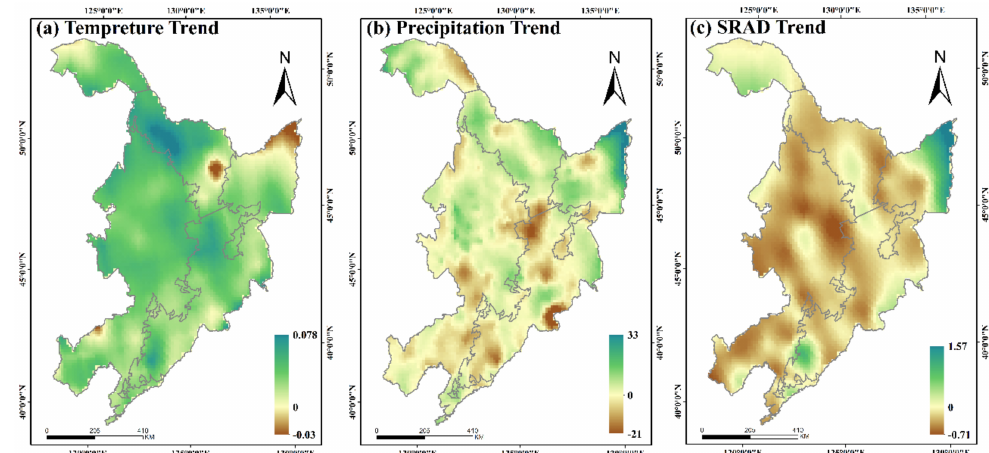
Figure 4. The inter-annual trend of ( a ) yearly average temperature, ( b ) yearly accumulated precipitation, and ( c ) yearly average SRAD (Shortwave Radiation) within the growing season across the NEC from 1982 to 2015.